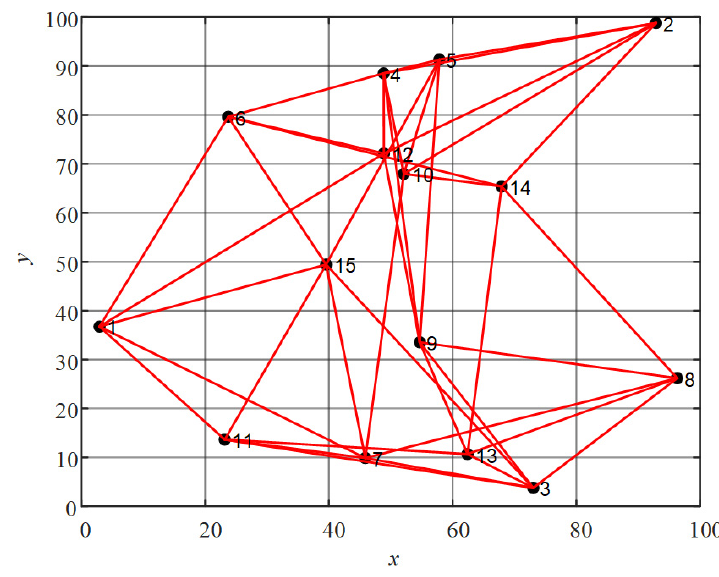
Figure 4. Optimized network